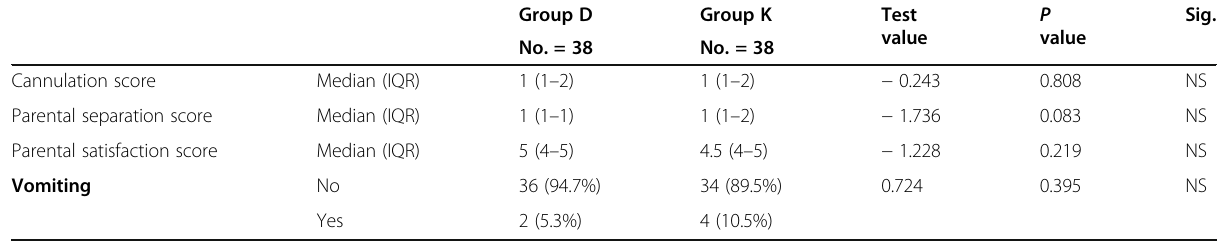
Table 11 Comparison between group D and group K as regards cannulation score, parental separation score, parental satisfaction score, and